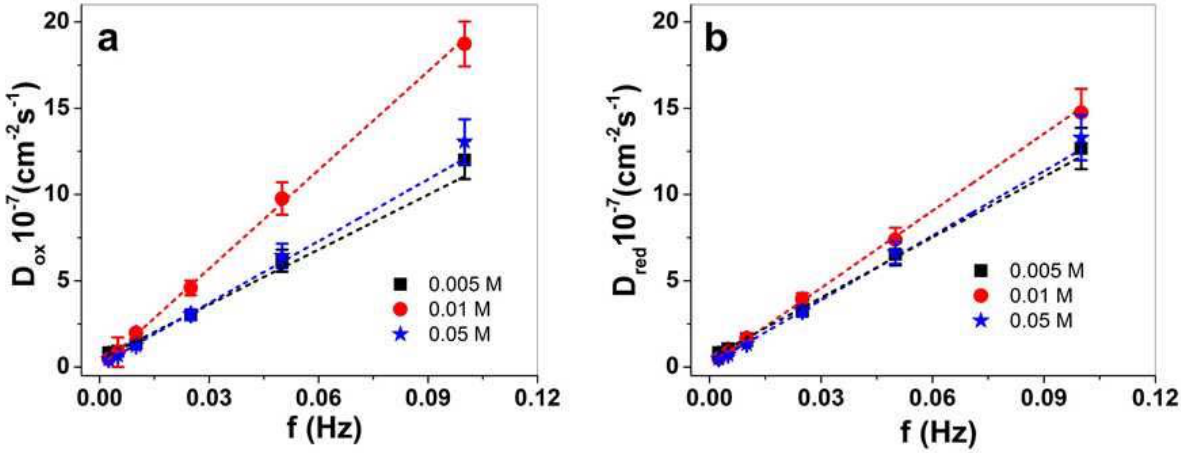
PTA concentrations during polymerization, such as 0.005 M (black line, ∎ ), 0.01 M (red line, ● ), and